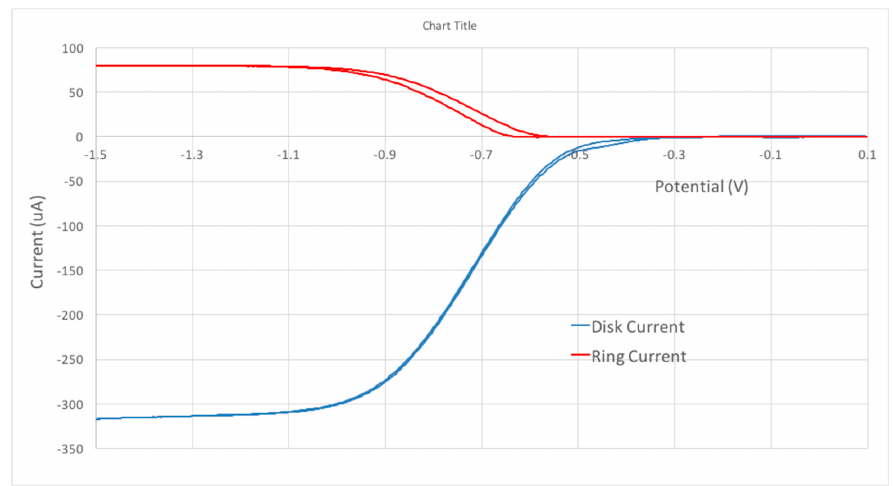
Figure 2 . The cathodic, bottom, and anodic, top, currents from the oxygen reduction to superoxide at the disk and subsequent oxidation back to oxygen at the ring. Solution is 0.1 M TBAB in dry DMSO, saturated with 1 atm O 2 .